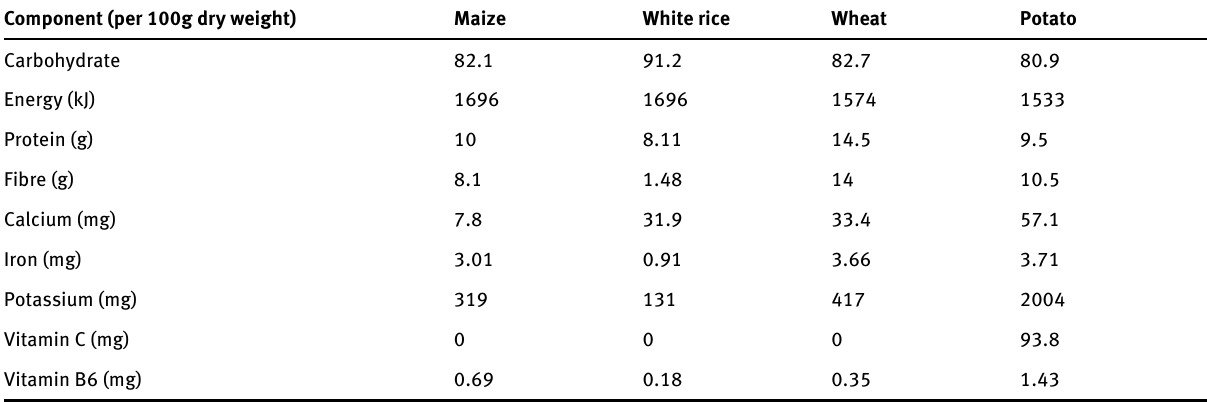
Table 2: Some components of the important staple